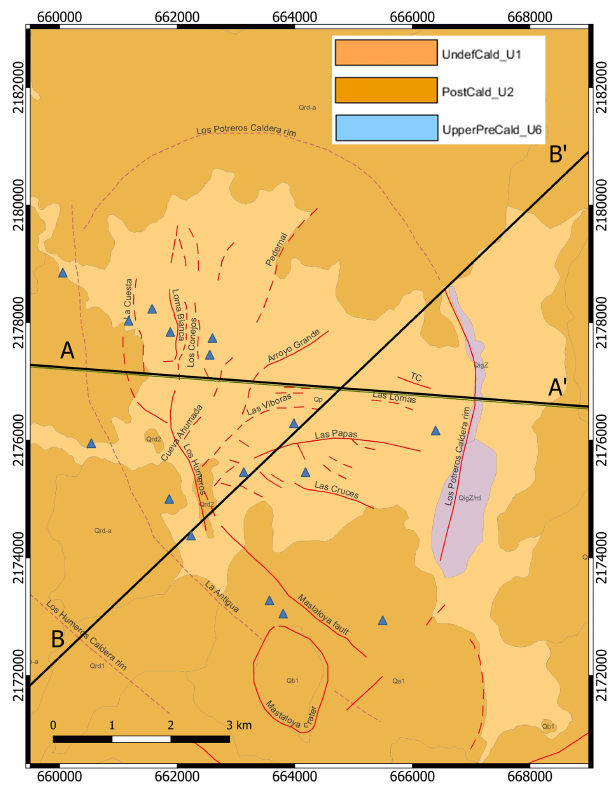
Figure 6. Los Humeros geological map reinterpreted from Carrasco-Núñez et al. (2017b) using the nine units selected for local scale modelling. Blue triangles: location of the sixteen wells used for modelling. AA’: Carrasco-Núñez et al. (2017a) cross-section, BB’: Norini et al. (2015) cross-section (see Fig. 8). Coordinate sys- tem is WGS84/UTM zone